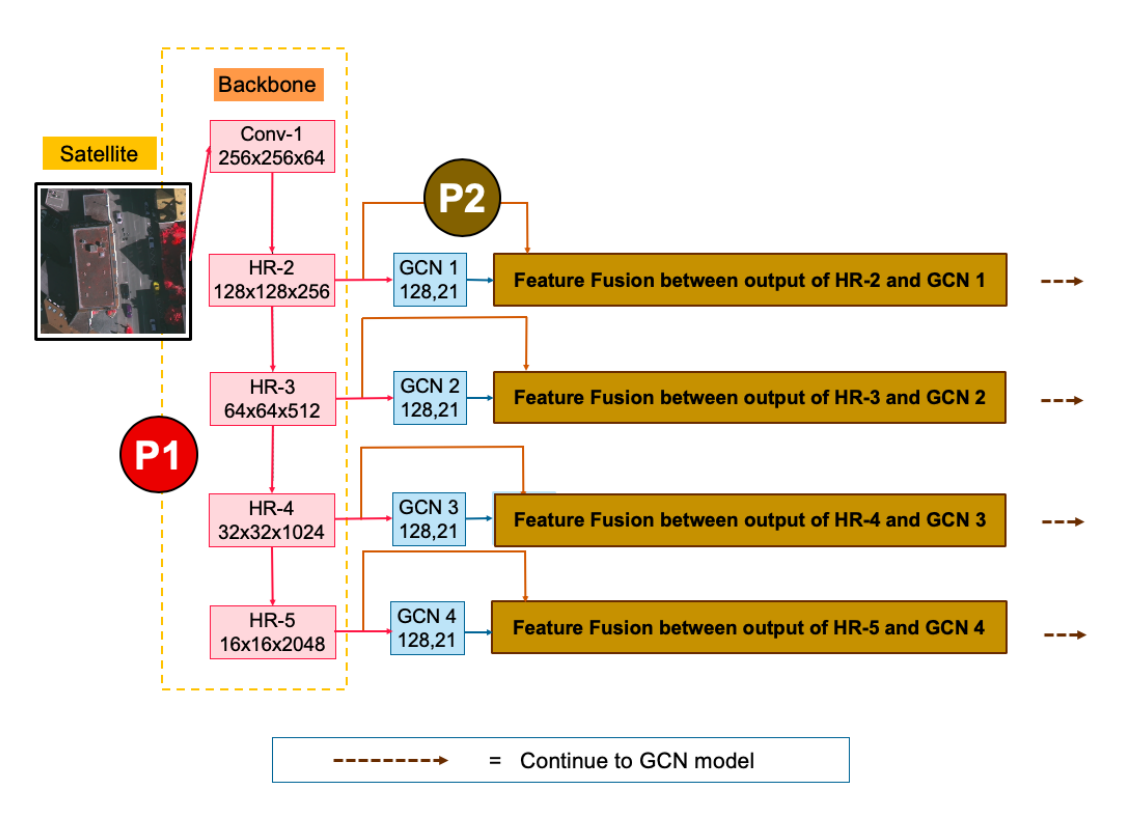
Figure 4. The framework of our feature fusion